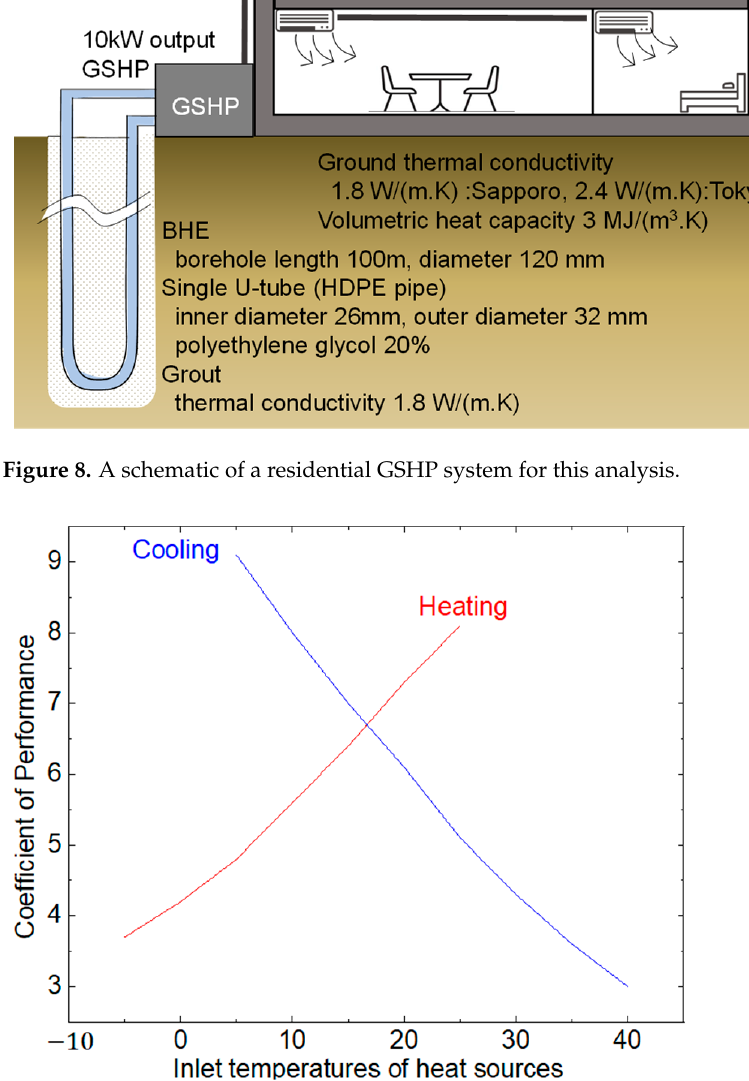
Figure 9. Relationship of coefficient of performance ( COP ) with inlet temperature of entering brine as heat source for a product of 10 kW GSHP.